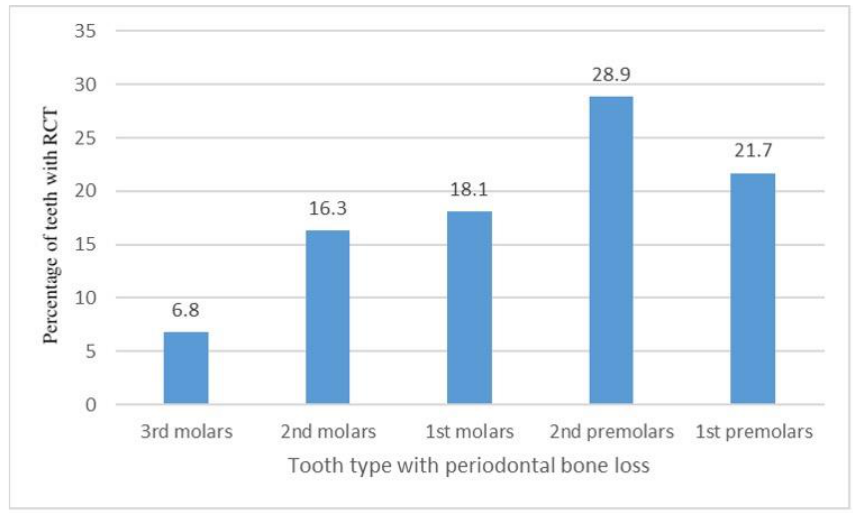
Figure 2. Types of teeth with crestal bone loss and their relation to previous root canal treatments (RCT).